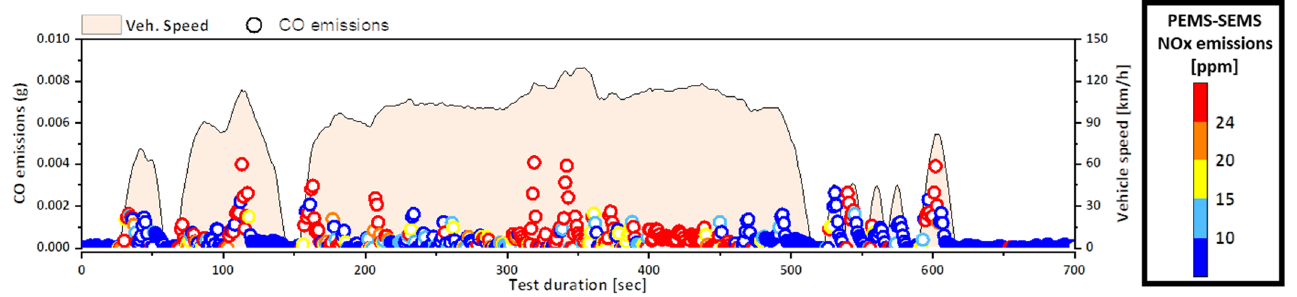
Figure 11. Real-time profiles of NOx emissions measured by the PEMS and SEMS equipment under various test modes in the laboratory .